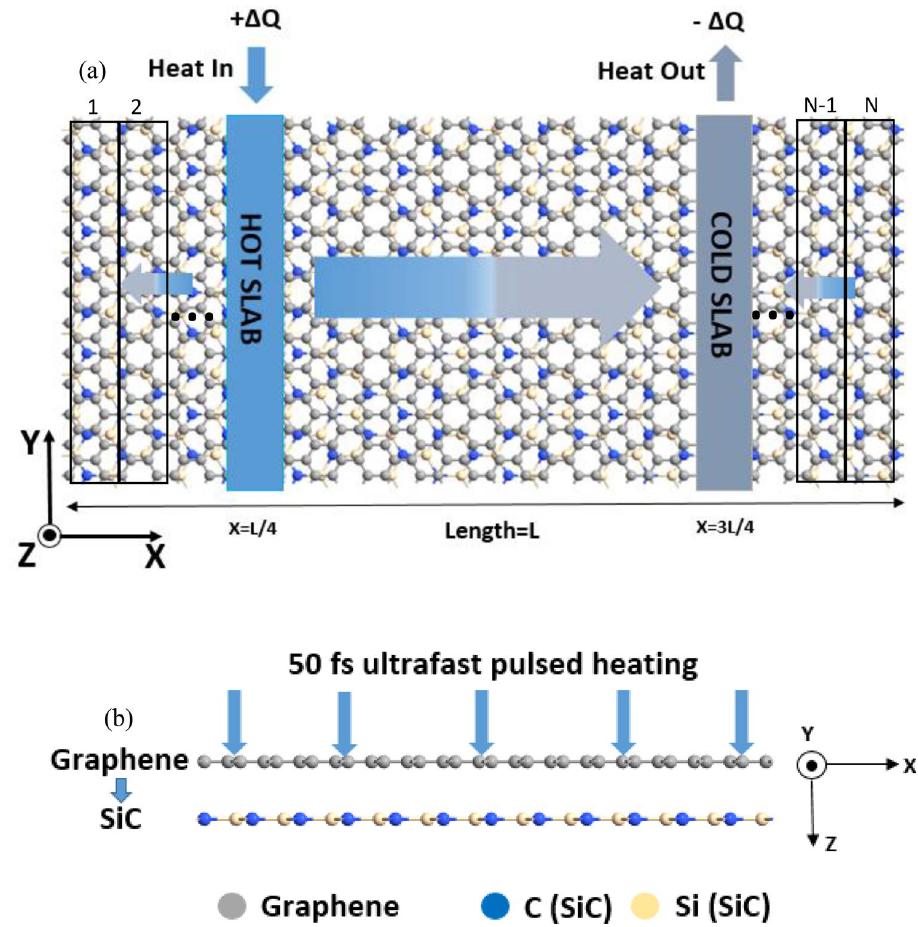
Figure 1. Atomic configuration of the graphene/2D-SiC van der Waals heterostructure (vdWH) used to calculate the ( a ) in-plane and ( b ) out-of-plane thermal conductivity. The + ∆Q amount of heat is applied to the hot slab (blue area) placed at the length of X = L/4 and − ∆Q amount of heat is extracted from the cold slab (gray area) placed at the length of X = 3L/4 in the x direction. Here, the blue to gray gradient arrow reflects the heat flow around the sheet length. A 50 fs ultra-fast heat impulse is applied to the graphene in the out-of-plane ( z ) direction to compute the interface thermal